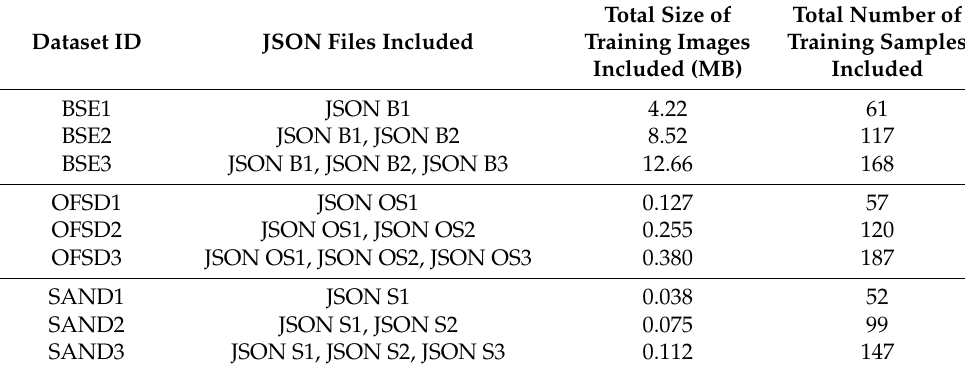
Figure 5. ( a ) The transmitted light microphotograph of offshore sandstone thin section. ( b ) Three JSON files with 57, 63, and 67 labeled grains. The JSON file with the green edge, purple edge, and yellow edge corresponding to the place circled by the green, purple, and yellow rectangles in ( a ). Table 1. The descriptions of datasets for models